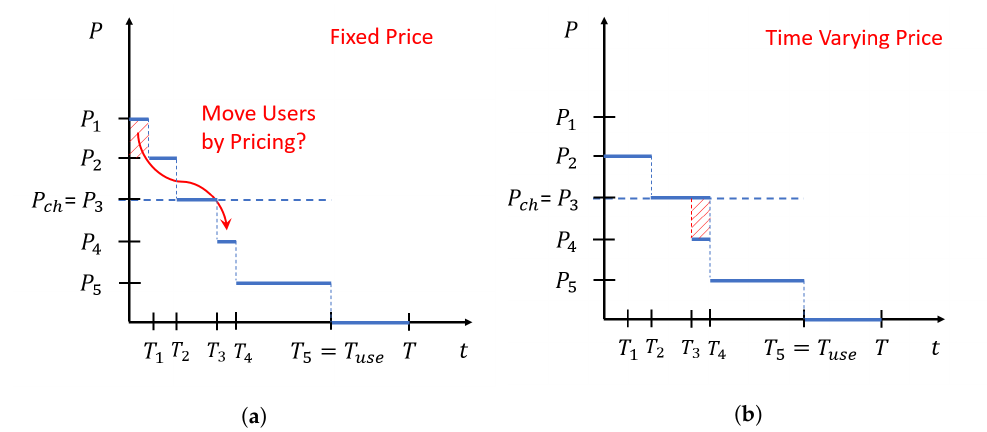
Figure 9. Example of charging power demand distribution. ( a ) The original demand. ( b ) A more even demand, with the price adjusted to reflect the demand. Thus, time-variable pricing may lead to greater charger